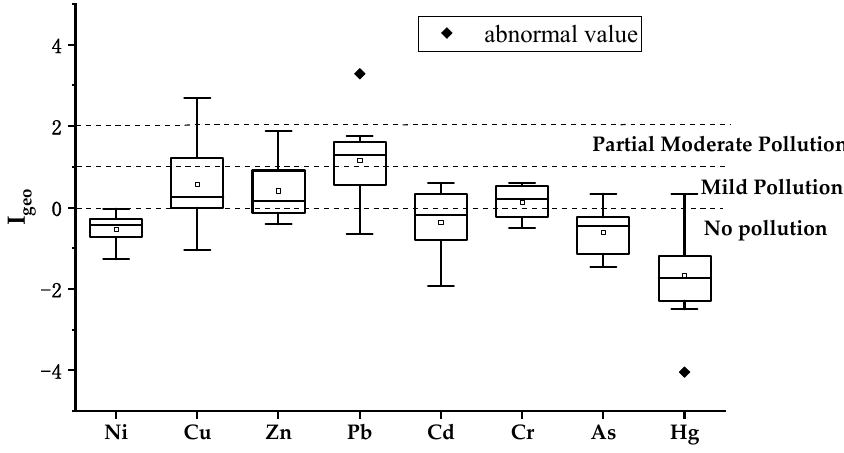
Figure 3. Geoaccumulation index of heavy metals in Three Gorges Reservoir.